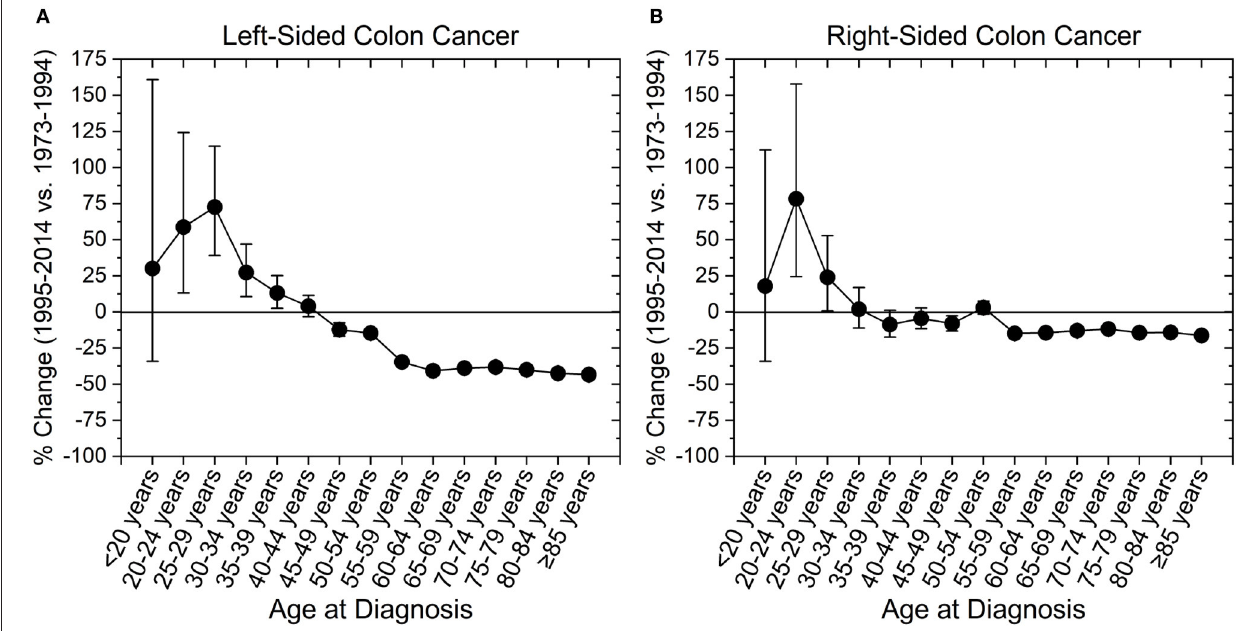
FIGURE 3 | Percent change in colon cancer incidence rate by colon side. Error bars represent 95% confidence intervals. (A) Left-sided colon cancer increased in incidence among those aged 20–39 years, while (B) right-sided colon cancer increased in those aged 20–29